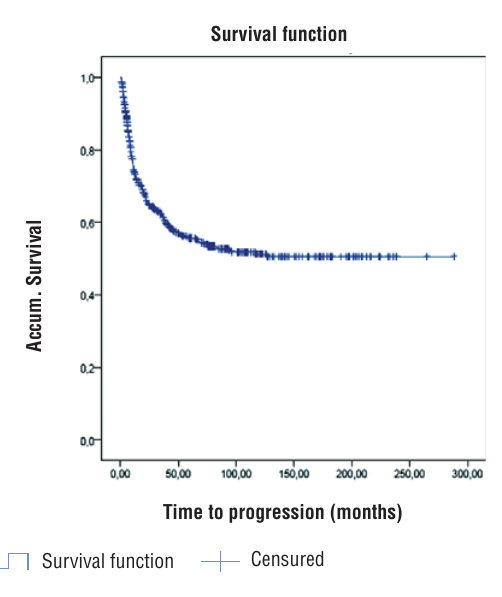
Figure 2 - PFS in 563